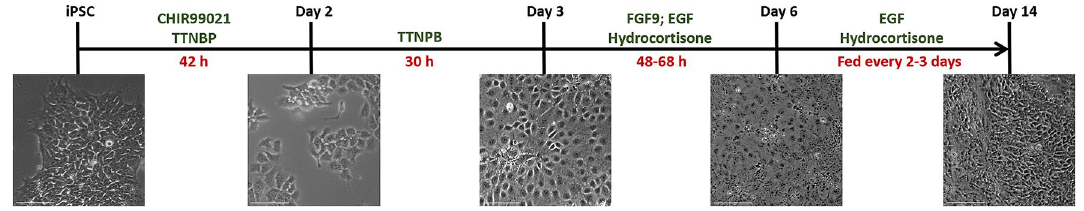
Figure 1. Schematic representation of the protocol to differentiate induced human Pluripotent Stem Cells (iPSC) into renal proximal tubule like (PTL) cells. Human iPSC were seeded on Geltrex coated cell culture wells and incubated with the indicated growth factors and chemicals in sequential steps for 14 days. Images were captured with a phase contrast microscope. The white scale bar represents 100